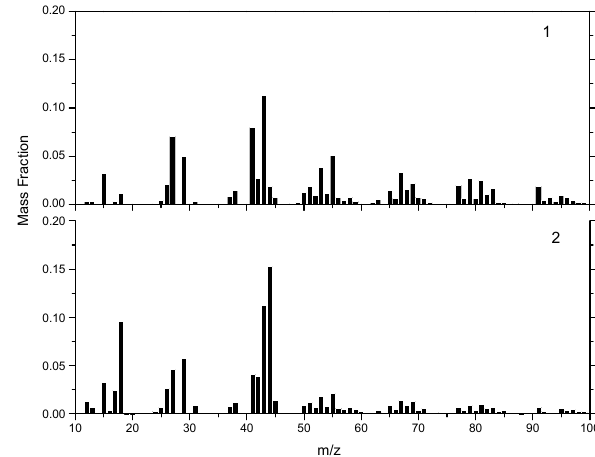
Fig. 4. Change in F44 and the O/C ratio as a function of OH ex- posure (bottom x-axis) and oxidation lifetime (top x-axis) for all SOA types (SOA1, SOA2, SOA3). O/C ratios were calculated from (Aiken et al., 2008). Error bars represent one standard deviation of 1 F44 values. Line represents error-weighted linear fit to the data forced through origin ( f(x) =(2.04( ± 0.03) × 10 5 ) x; R 2 =0.87).